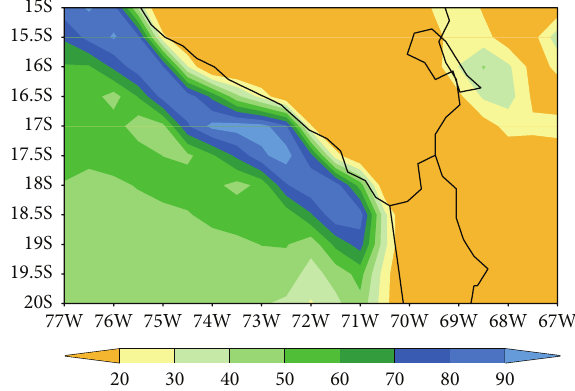
Figure 5: CFS reanalysis JJA climatology 1979–2009 total cloud shaded (units: percent).